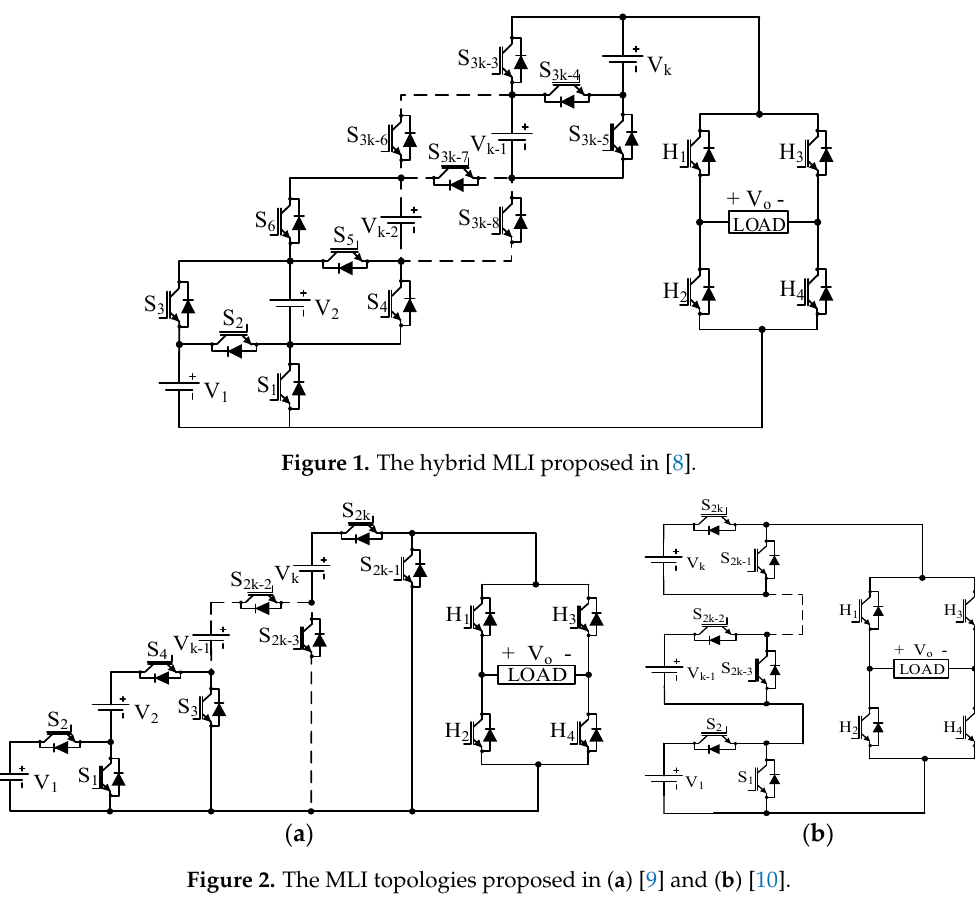
Figure 2. The MLI topologies proposed in ( a ) [9] and ( b ) [10].